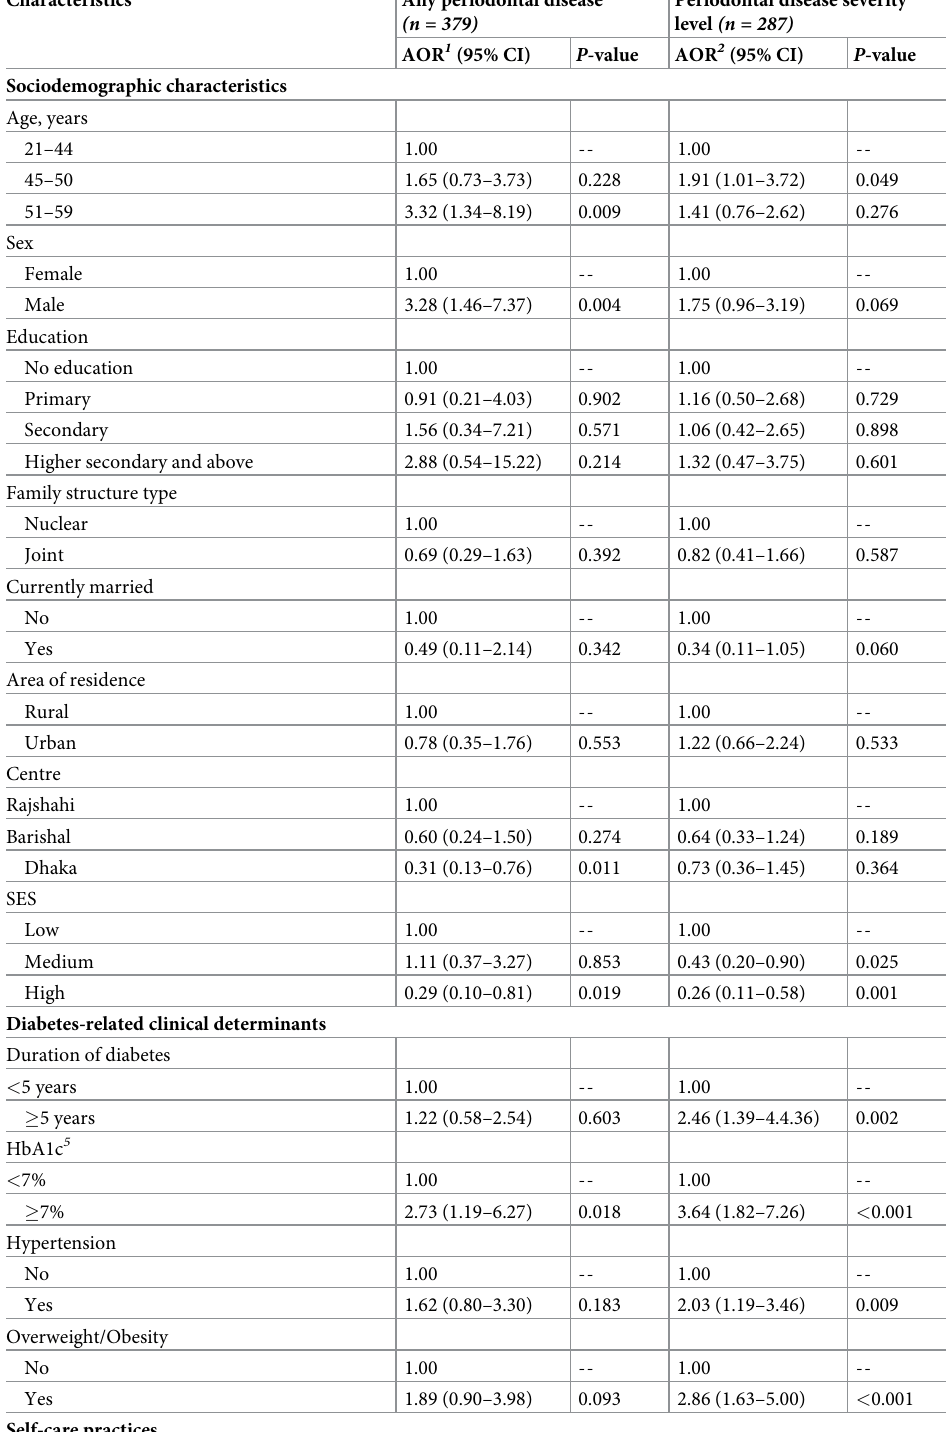
Table 2. Adjusted odds ratios (AOR) for associations between sociodemographic characteristics, diabetes-related clinical determinants, self-care practices, and oral hygiene practices according to periodontal disease and its sever- ity among individuals with type 2